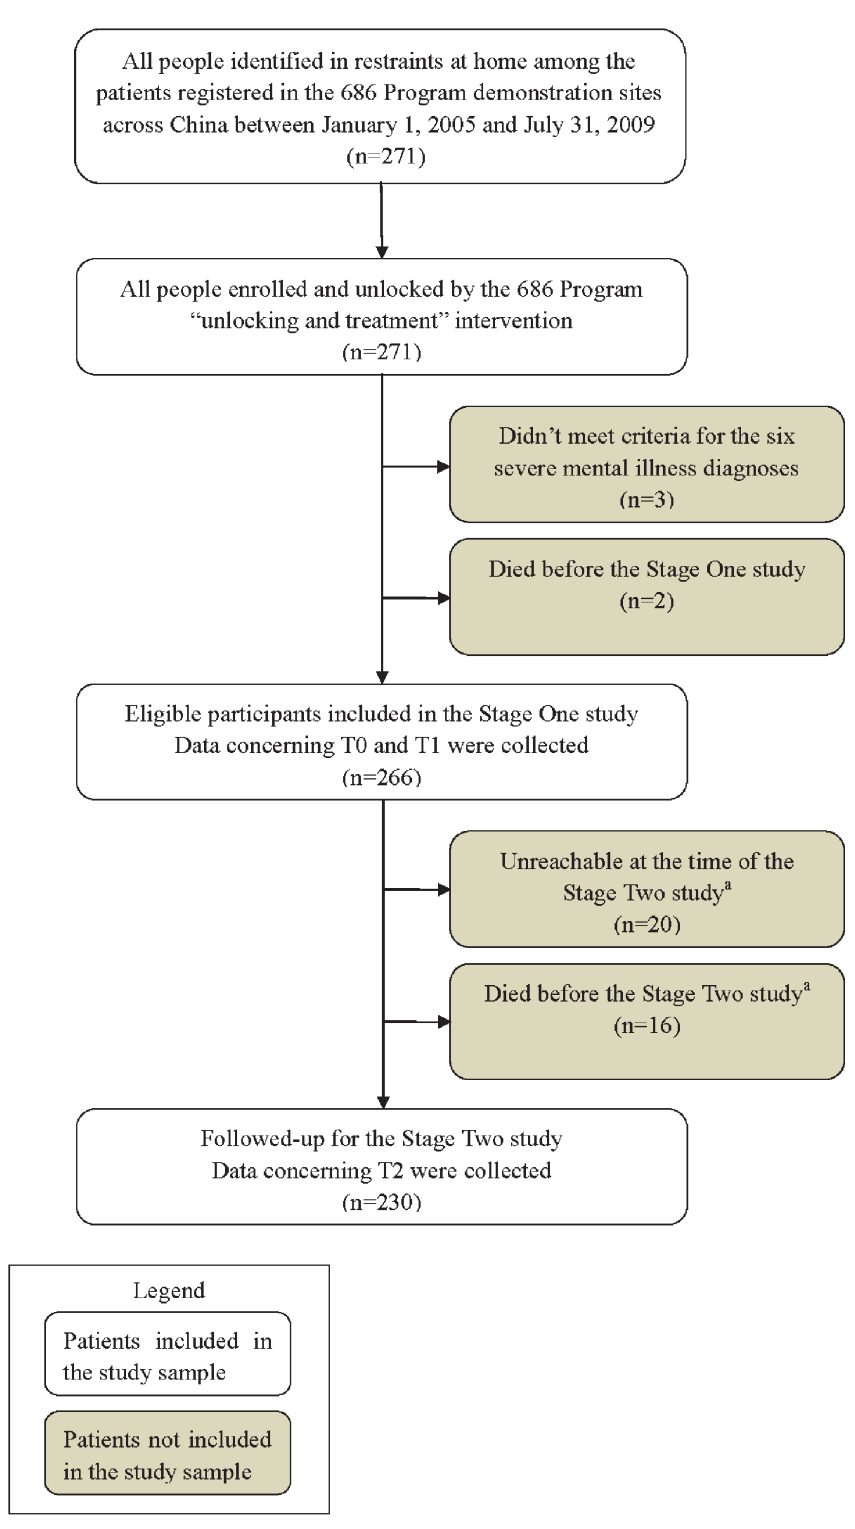
Fig 1. Study profile. a 36 patients who were not included in the Stage Two study aged from 18 to 61 (mean 40.1 [SD 12.1]). 31 (86%) were male and 28 (78%) were from rural area. 20 (56%) were unreachable due to moving and other